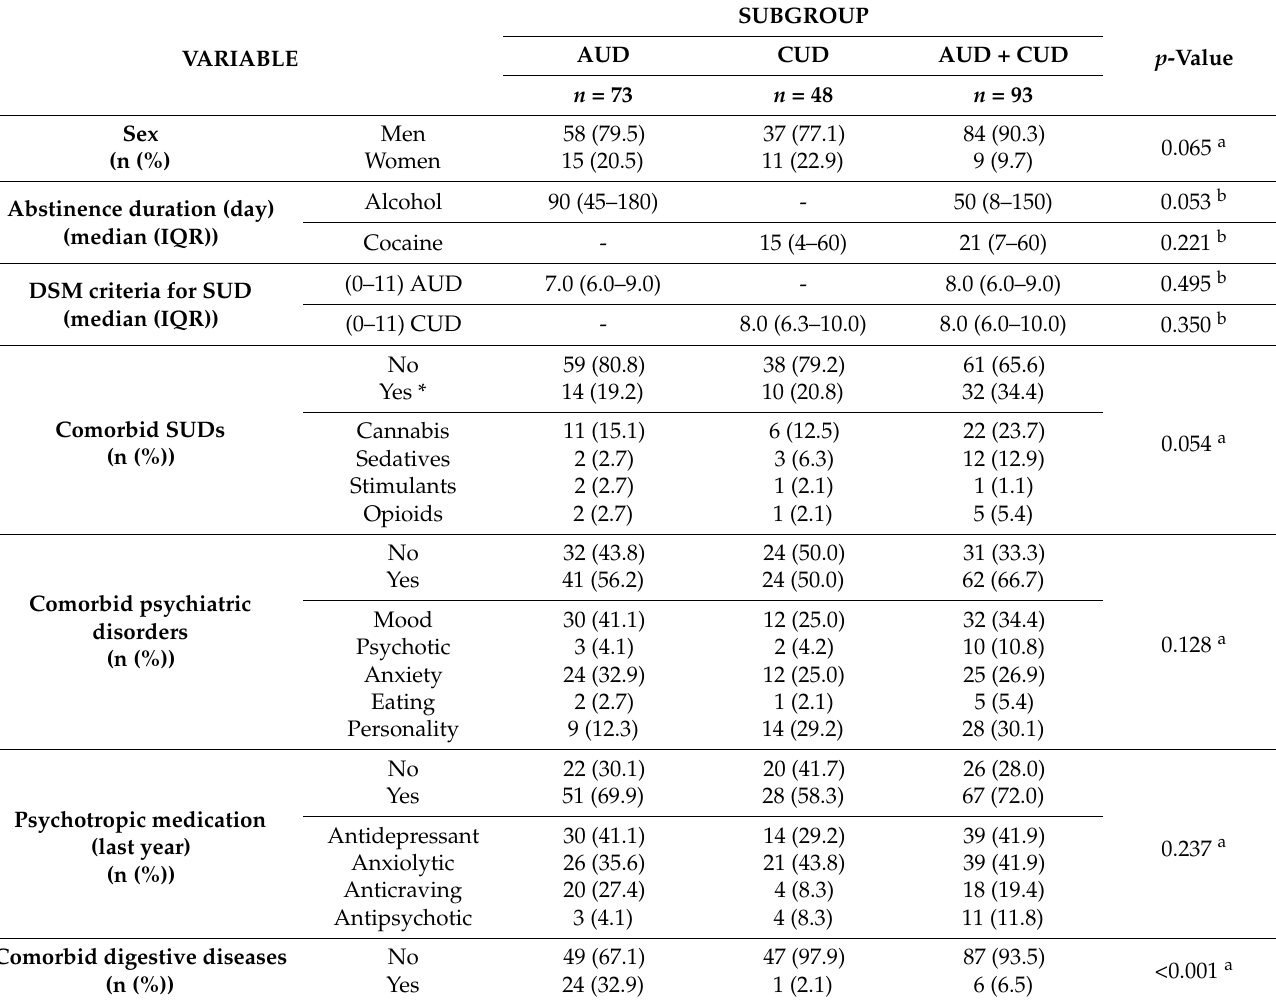
Table 4. Clinical and psychiatric variables of the SUD group based on subgroups of